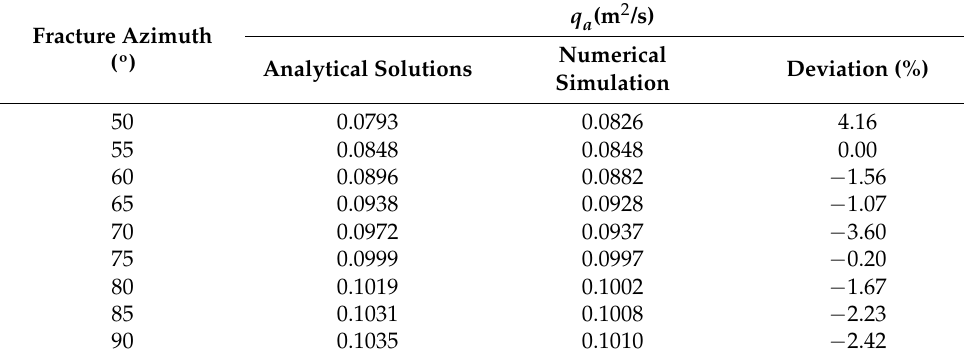
Table 3. Comparison of the simulation results for different simple fracture networks with analytical solutions.